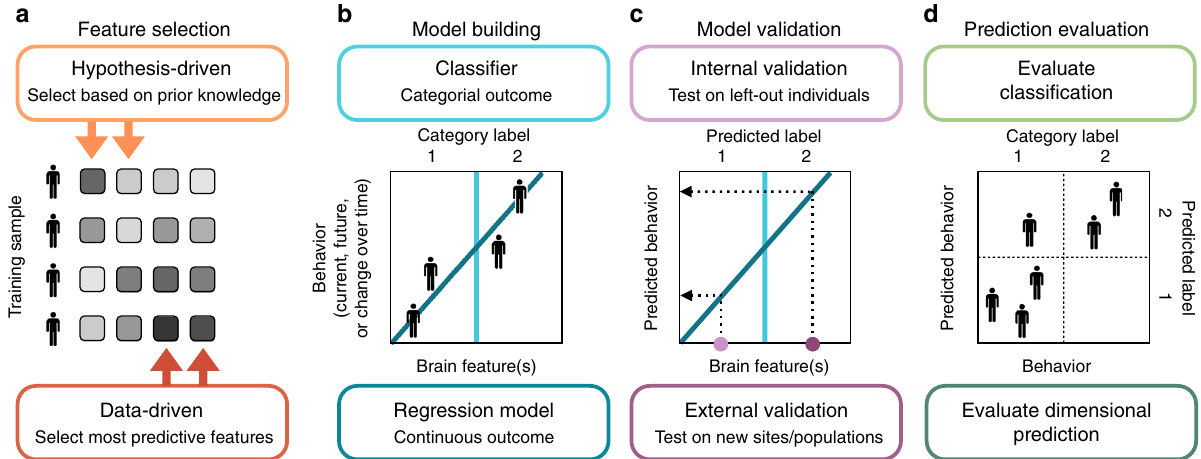
Fig. 2 Schema of key concepts in predicting individual differences in behavior from brain features. a Feature selection. Feature selection techniques fall into two broad categories: hypothesis-driven (top-down) and data-driven (bottom up) approaches. b Model building. Machine-learning algorithms can be used to predict categorical measures, such as clinical diagnoses, or dimensional measures, such as task performance or symptom severity. Here, the dark blue line shows the relationship between a single hypothetical brain feature and a behavioral score. The light blue line illustrates a classi fi er that divides individuals into categories based on this brain feature. (Note that, unlike in this condensed visualization, behavioral scores are typically related to category labels.) c Model validation. Predictive models are evaluated on previously unseen data — either left-out individuals from the initial data set (internal validation) or individuals from a completely new sample (external validation). d Prediction evaluation. Continuous predictions (bottom and left axes) are evaluated by comparing observed and predicted behavioral measures, e.g., with correlation or mean-squared error. Categorical predictions (top and right axes) are evaluated with percent correct; binary predictions can be assessed with sensitivity and speci fi city and/or positive and negative predictive